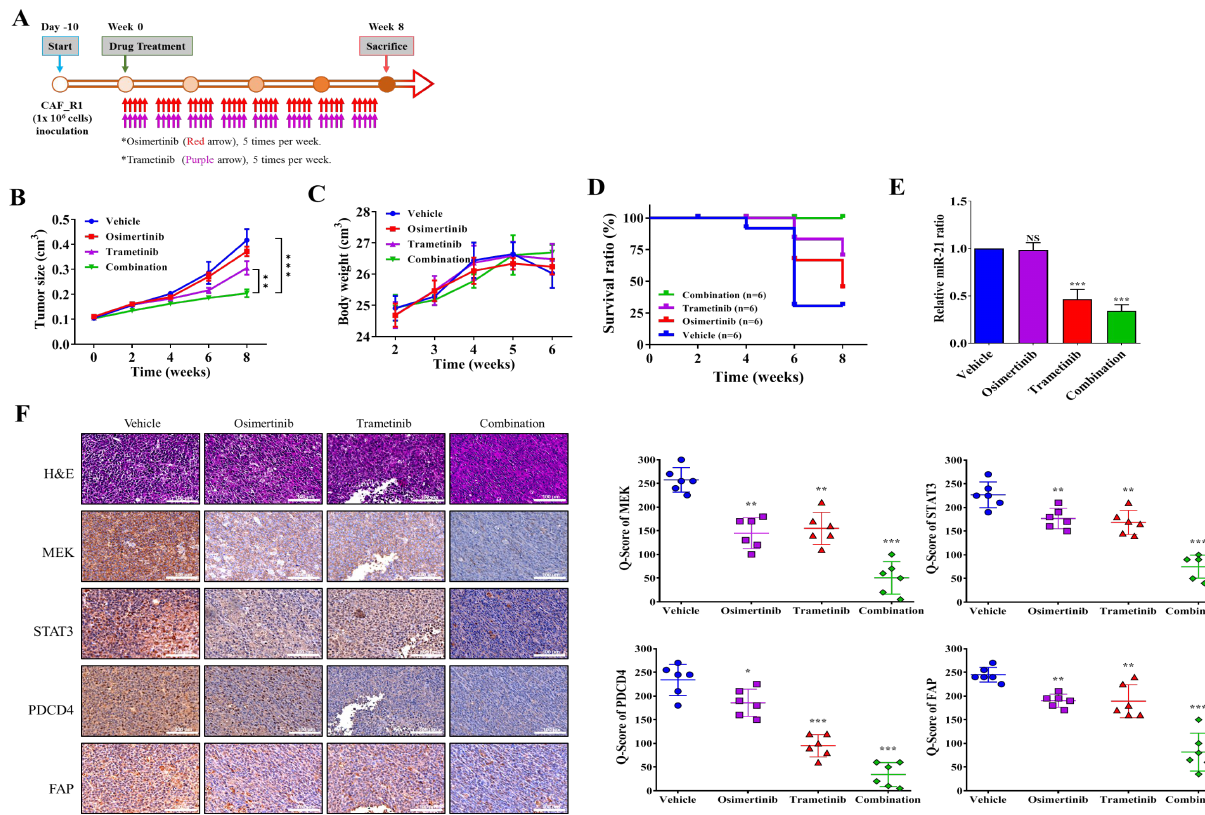
Figure 5 Figure 5. Combined treatment of Trametinib and Osimertinib effectively inhibited the growth of P_AZDR1 (Osimertinib resistant) cells in vivo. ( A ) The flow chart for in vivo experimental design and treatment schedule. ( B ) Tumor curve over time shows that the combination of Trametinib and Osimertinib suppressed the tumor growth the most followed by the Trametinib alone group as compared to the vehicle and Osimertinib groups (no significant difference between these two groups). ( C ) Bodyweight over time curve demonstrated no apparent systematic toxicity in the mice receiving combined treatment. ( D ) Kaplan-Meier survival curve shows that the mice that received the combined treatment exhibited the highest survival ratio as compared to the rest. ( E ) Real-time PCR results of the tumor samples revealed that the miR-21-5p level was most significantly suppressed in the combined treatment followed by the Trametinib group while no significant difference was observed between vehicle and Osimertinib groups. ( F ) Immunostaining analysis of PDX tumor sections showed that the combined treatment most prominently suppressed the expression of MEK, ERK, STAT3 and PDCD4 but an increased E-cadherin was observed, compared to other sections. * p < 0.05; ** p < 0.01; *** p < 0.001. NS, not significantly different. PDX: patient-derived